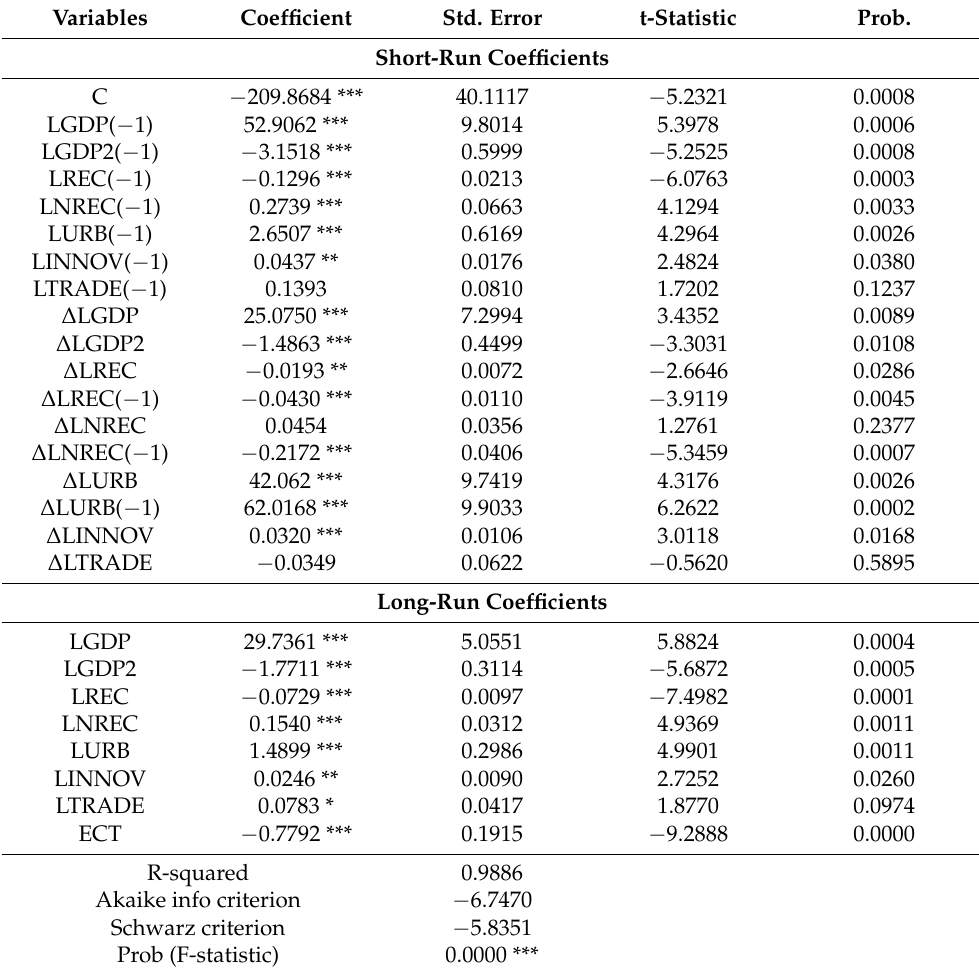
Table 7. Estimated Short-run and Long-run